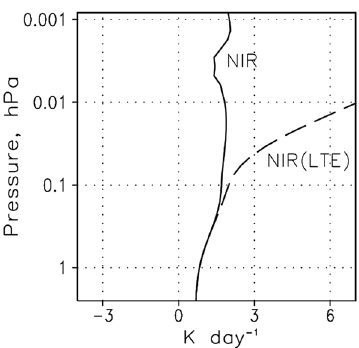
Fig. 7. Total heating due to solar energy absorption in the near-IR CO 2 (NIR) bands. This illustrates the difference in heating in K day (cid:4) 1 when the Local Thermodynamic Equilibrium (LTE) approximation is made. This approximation breaks down at around 0.1 hPa (approx. 65 km) as can be seen. After Fomichev et al. (2004).